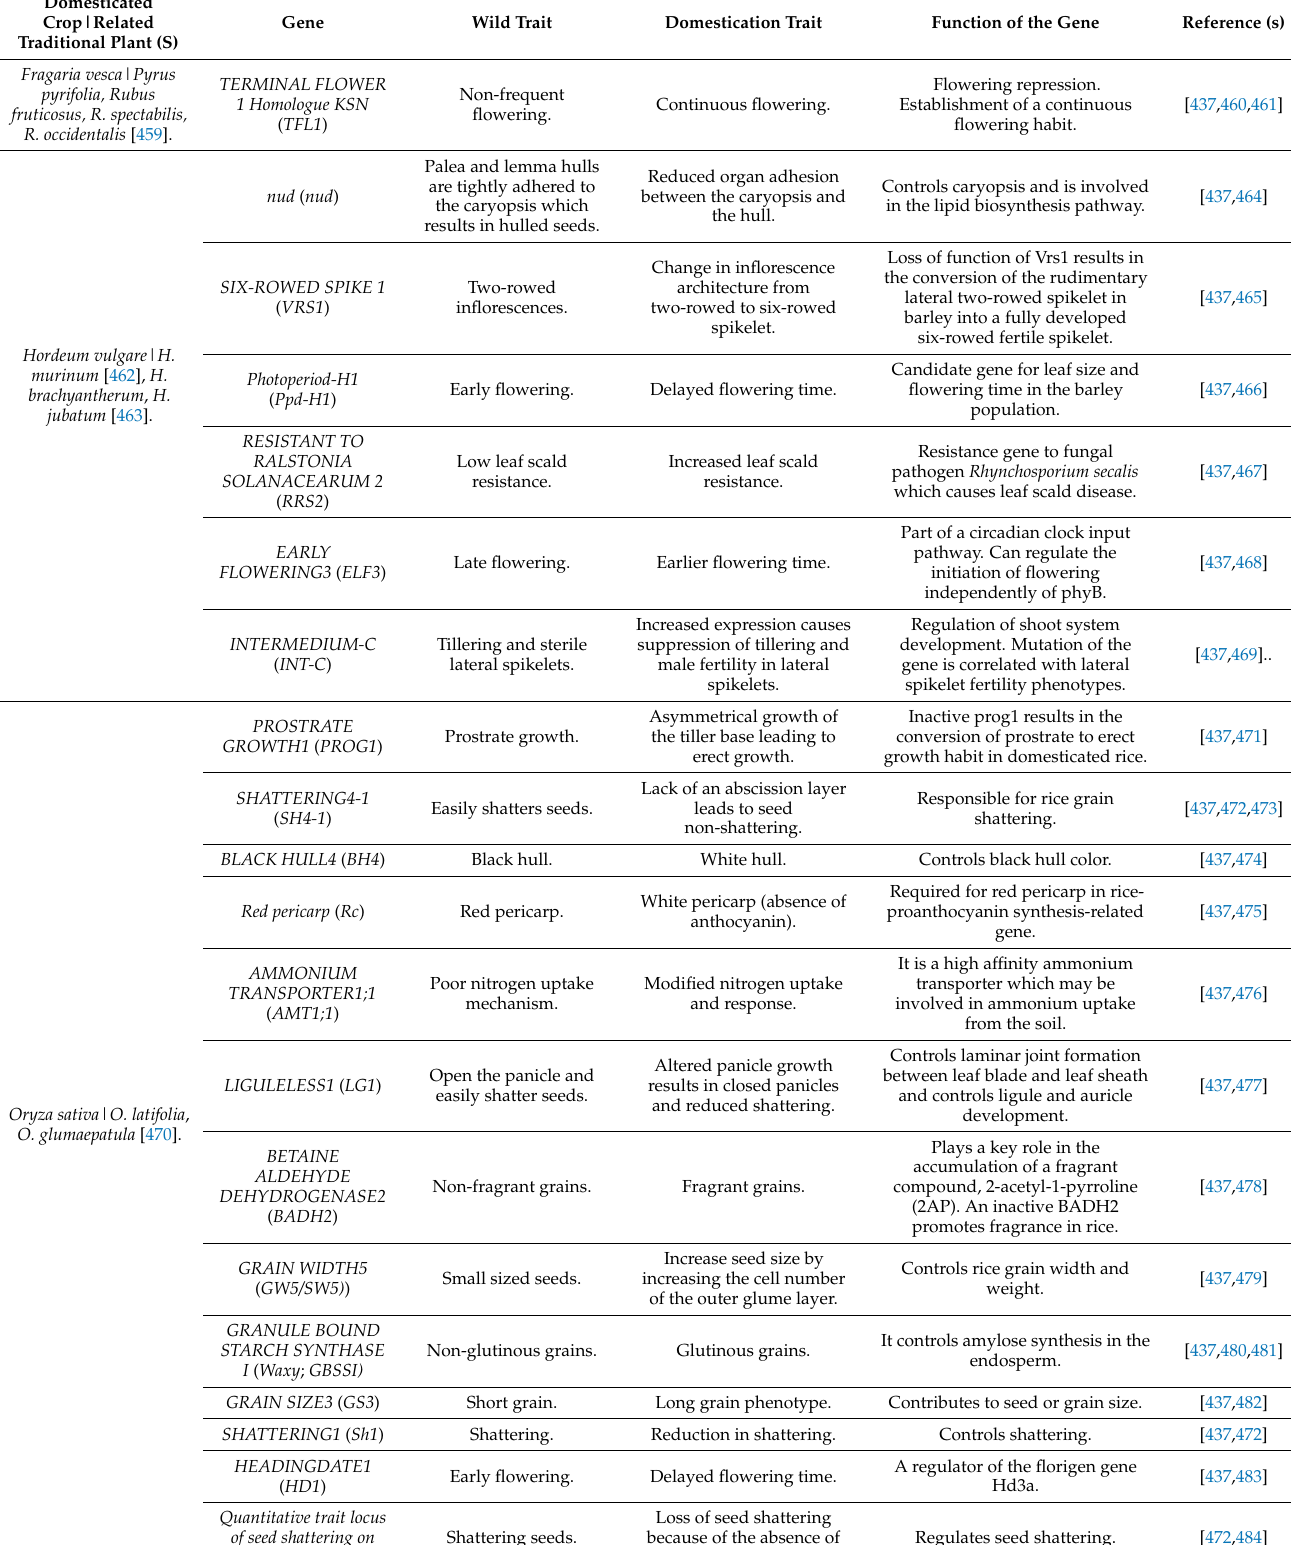
Table 3. Genes governing major domestication traits in crop plants related to traditional food plants